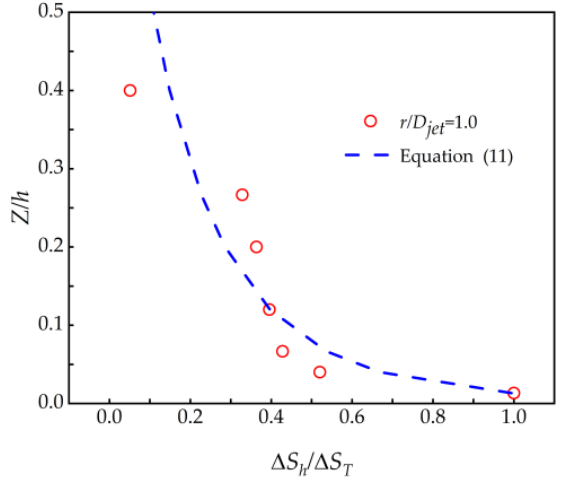
Figure 15. Variation of speedup ratio with vertical height.